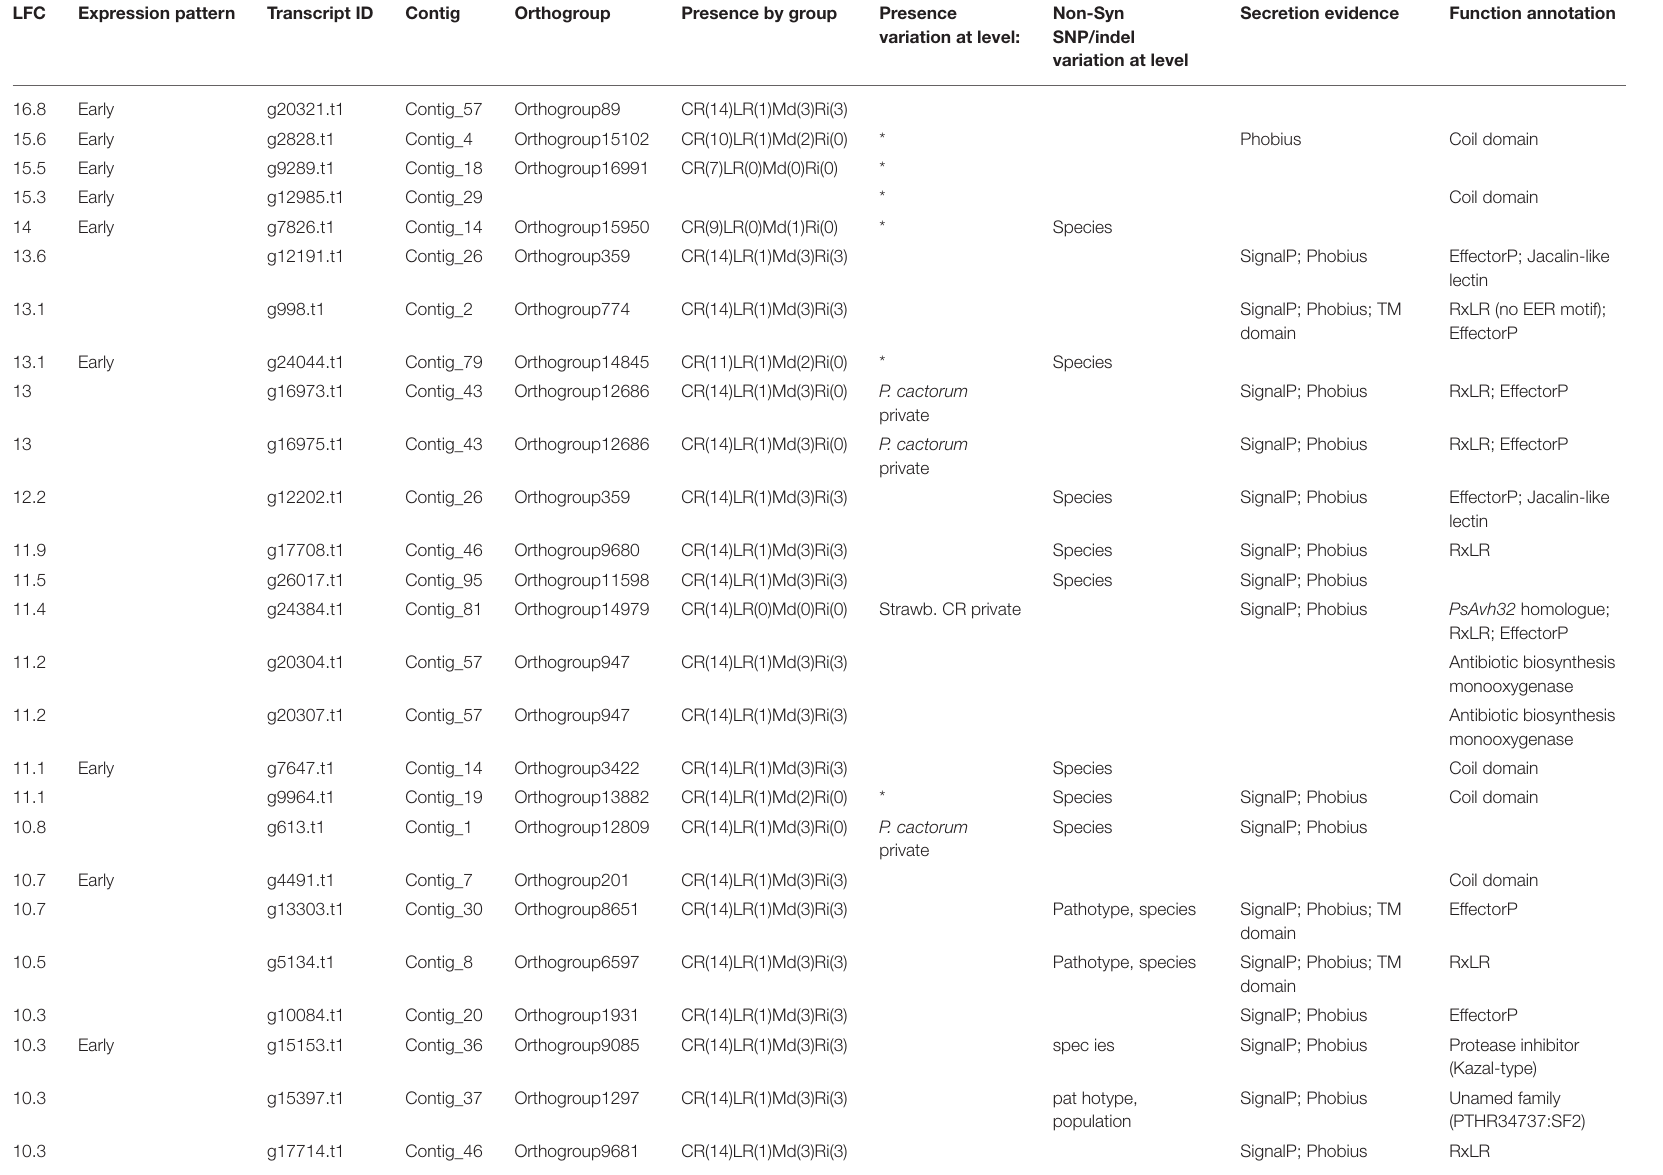
Transcripts were ranked by log fold change (LFC) in descending order. Gene families expanded, private to Phytophthora cactorum, or private to the strawberry crown rot (CR) lineage were identified. Functional annotation of proteins provide evidence for effector candidates. * denotes orthogroups that could not be